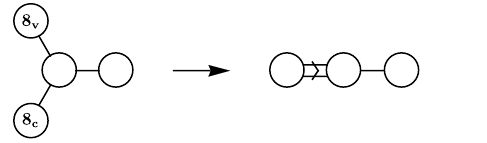
Figure 9 . The outer-automorphism acting on the D 4 diagram of so 8 leads to the B 3 diagram of so 7